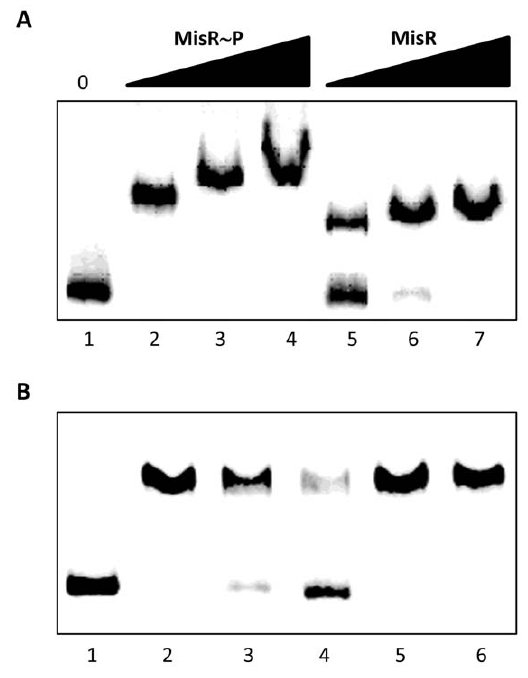
Figure 5. MisR directly binds to the synA-ctrA promoter region. Panel A. MisR interacts with the cps intergenic probe containing both the synA and ctrA promoters. Phoshorylated MisR (MisR , P, Lanes 2–4) and MisR (lanes 5–7) binds the probe in a dose-dependent manner. Lane 1 contains probe alone, Lanes 2 and 5 contain 68 pmol of protein; lanes 3 and 6 contain 136 pmol of protein; lanes 4 and 7 contain 204 pmol of protein. Panel B. Competition EMSA. The mobility shift of the labeled probe by MisR , P (136 pmol, lane 2) relative to labeled probe without protein (lane 1) was competed away by unlabelled probe (1 m g in lane 3 and 2 m g in lane 4). This interaction between MisR , P and the labeled probe was specific as the complex remained intact and could not be competed away when cold, unlabeled non- specific DNA was added (1 m g in lane 5 and 2 m g in lane 6).